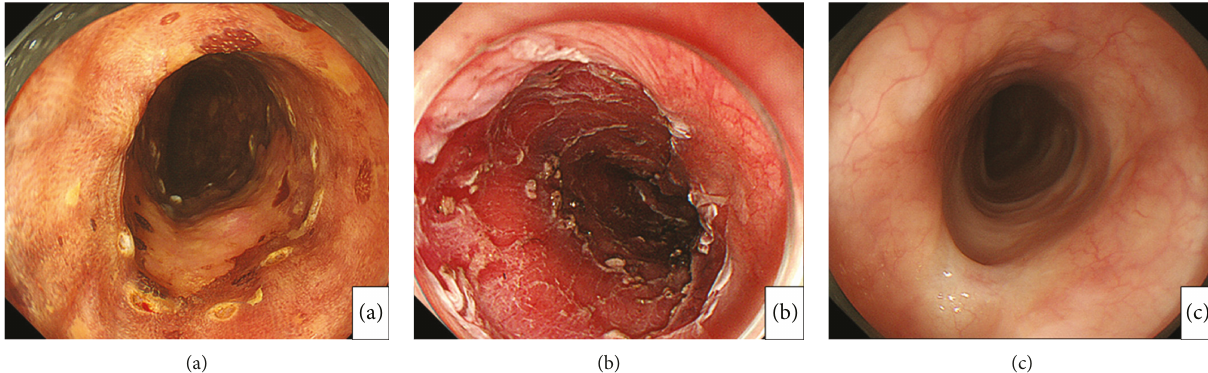
Figure 1: Endoscopic fi ndings in a case of endoscopic submucosal dissection (patient number 20) 0-llb, more than 2/3 circumferential lesion. (a) Chromoendoscopy with iodine staining (with marking around the lesion). (b) Arti fi cial ulcer after 4/5 circumferential resection. (c) Arti fi cial ulcer scar with mild stenosis 8 weeks after endoscopic submucosal